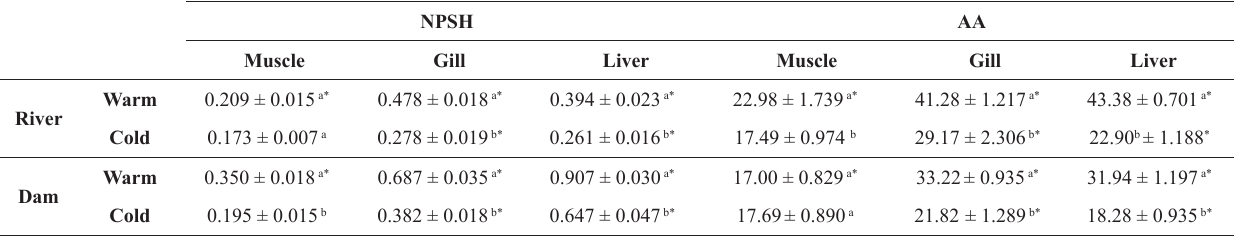
Fig. 2. Levels of the biomarkers TBARS (a - c) and GST (d - f) in muscle (a, d), gill (b, e) and liver (c, f) of Astyanax jacuhiensis from river (gray bars) and dam (white bars) sampled in warm and cold seasons from Uruguai basin. N = 10. Different letters represent significant differences between seasons of the same environment (river or dam). Asterisks represent significant differences between environments in the same season. By unpaired t test, with Welch’s correction. Table 3. Variations of biomarkers in Astyanax jacuhiensis samples obtained from two environments from rio Uruguai basin. NPSH expressed in µmol SH g tissue -1 , and AA expressed in µmol g tissue -1 (n = 10). Different letters in a column represent significant differences between seasons of an environment (river or dam). Asterisks represent significant differences between environments in a same season. By one-way ANOVA test fallowed by unpaired t test, with Welch’s